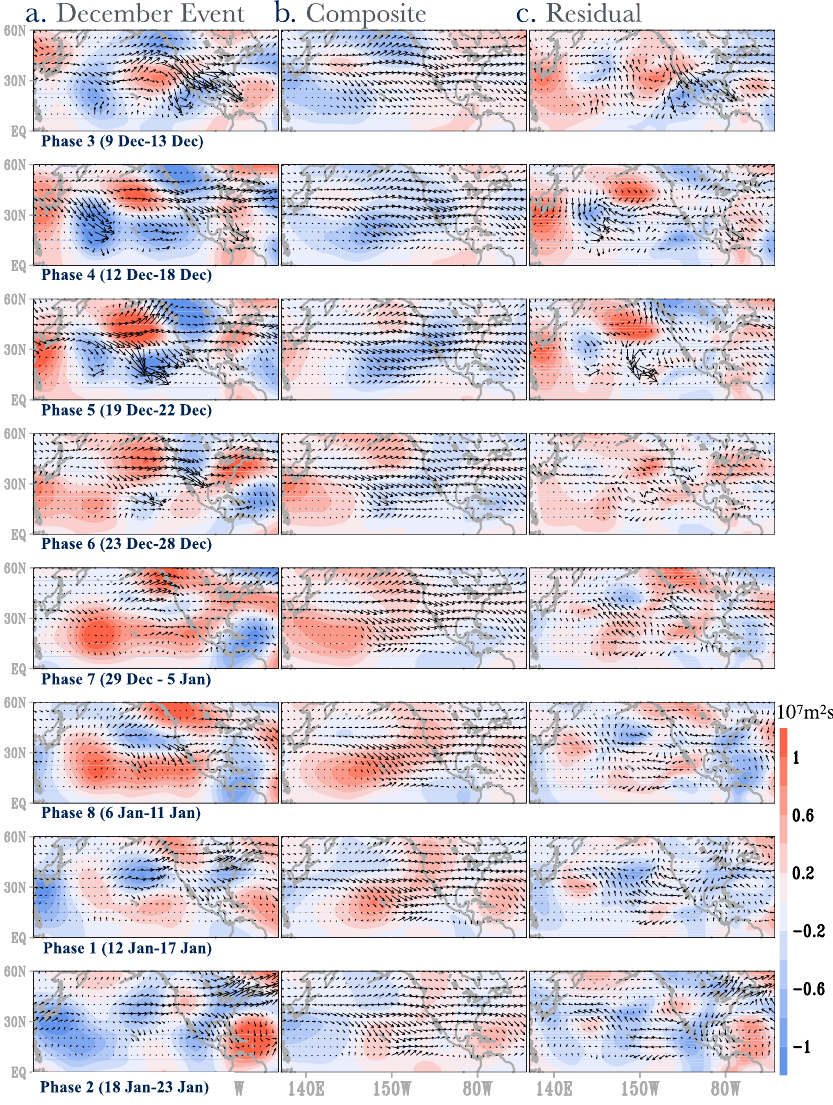
Figure 4. ( a ) 200-hPa streamfunction anomalies based on the eight phases of the December 2015 MJO episode described in the text; ( b ) Composite of 200-hPa streamfunction anomalies based on 25 prior MJO episodes; ( c ) Streamfunction anomalies not linearly explained by the MJO and ENSO (i.e., linearly regressed constructed impact of both the MJO and ENSO subtracted from the December event anomalies of Ψ ). Corresponding wave-activity fluxes are superimposed in vectors.